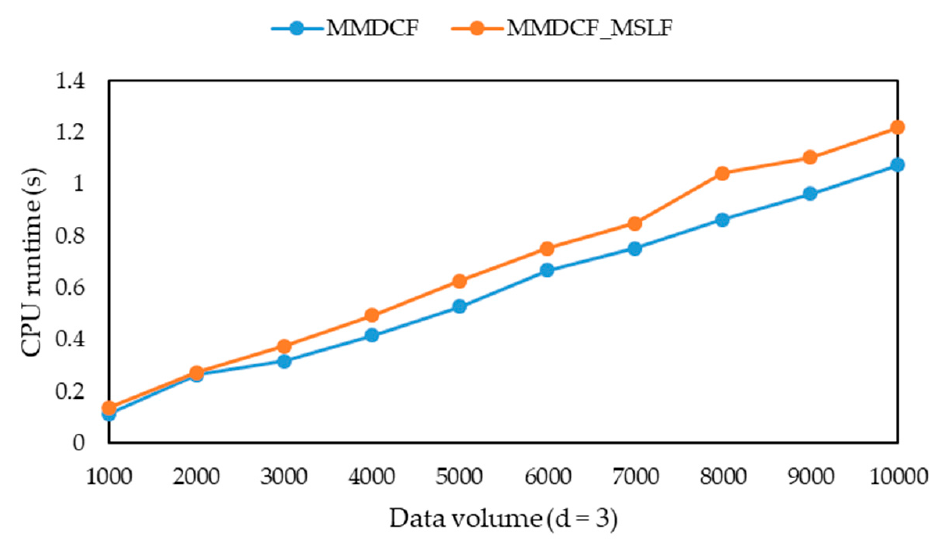
Figure 15. The suppression ratio of MMDCF and MMDCF-MSLF with different data volumes ( d = 3).